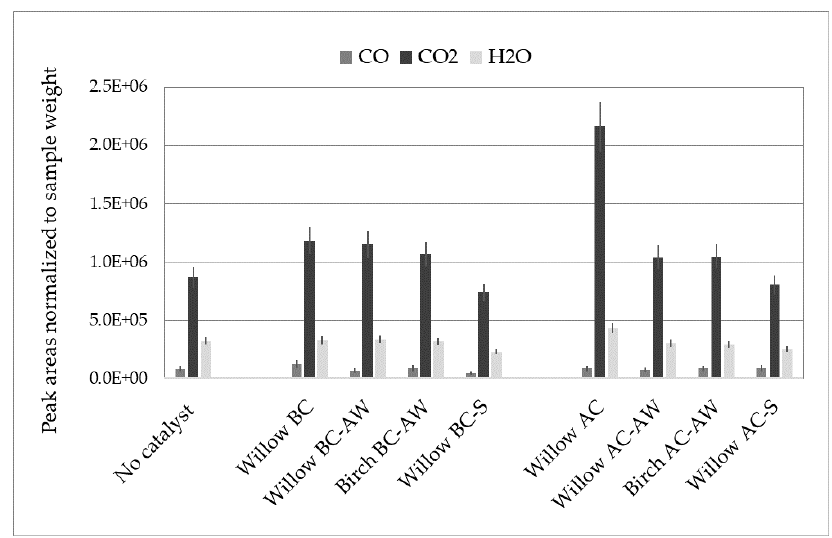
Figure 1. Gas and water release in thermal pyrolysis and after post-treatment. Compounds determined by GC/MSD. BC = biochar, AW = acid washed, S = sulfonated, AC = activated carbon.